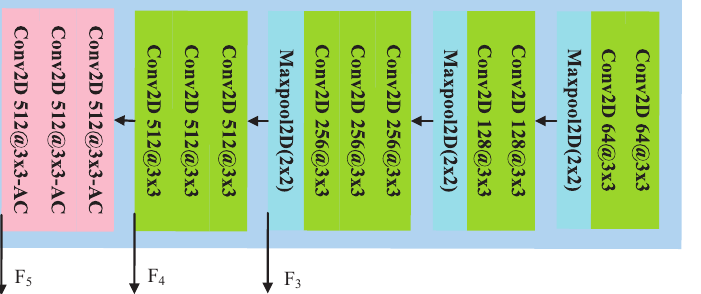
Figure 2. Parameter settings of feature extractor. “3 × 3” represents the kernel size of convolutional layers, “64”, “128” and “512” stand for the number of filters, and “AC” indicates the default setting, r s = 2 for atrous convolutional